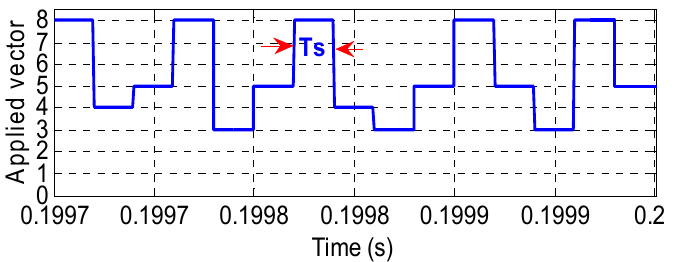
Figure 14. Steady-state performance of qZSI during 0.0003 s in boosting mode without modulated MPC at 20 μs , with 15 vectors transitions.